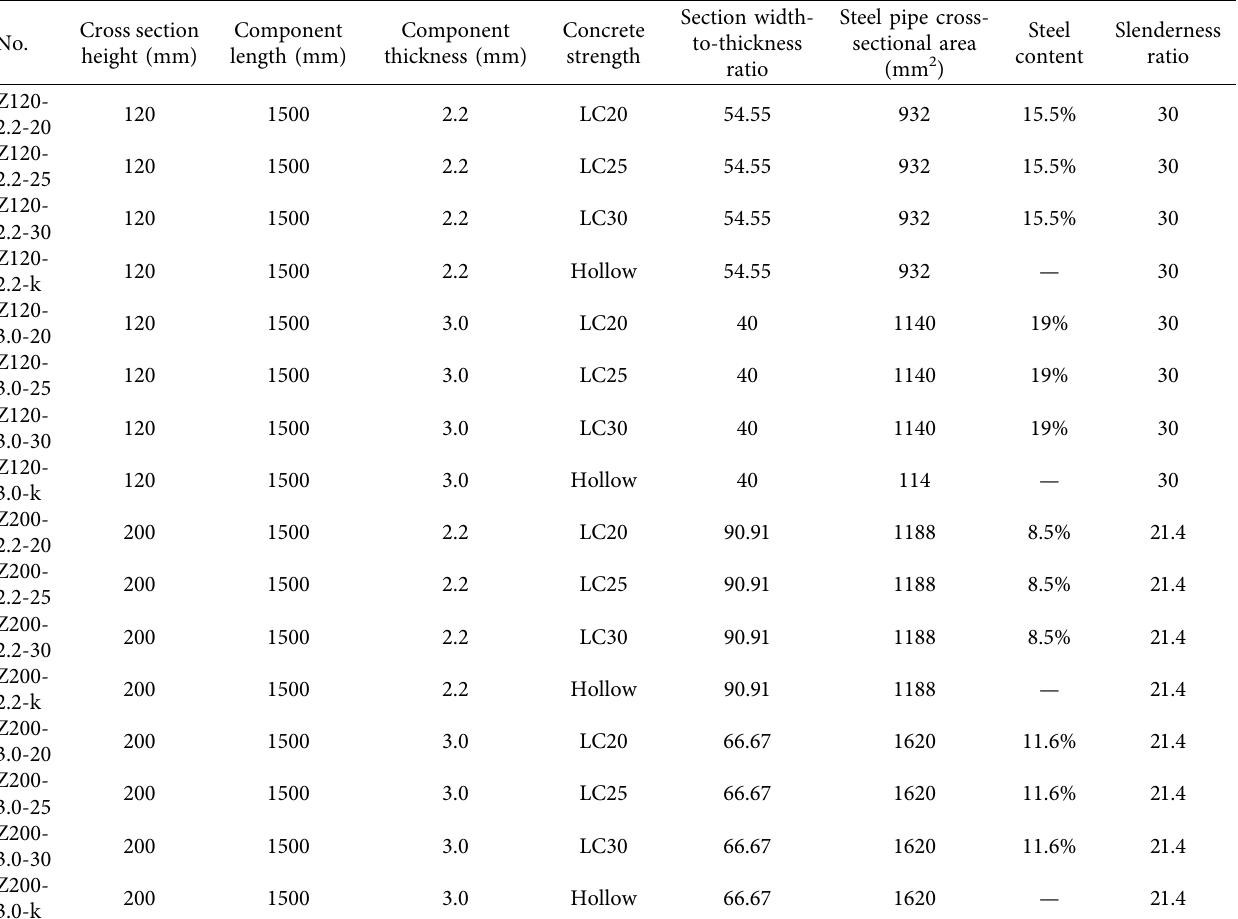
Figure 1: Manufacturing process of the specimen. (a) Hollow built-up column. (b) Concrete pouring process. (c) Processed specimens. Table 1: Parameters of the